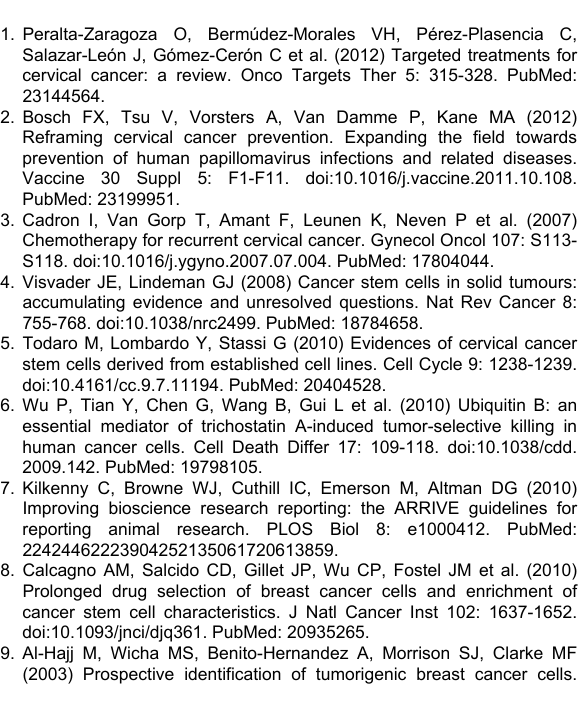
Table S1. Quantitative RT-PCR primers used in this